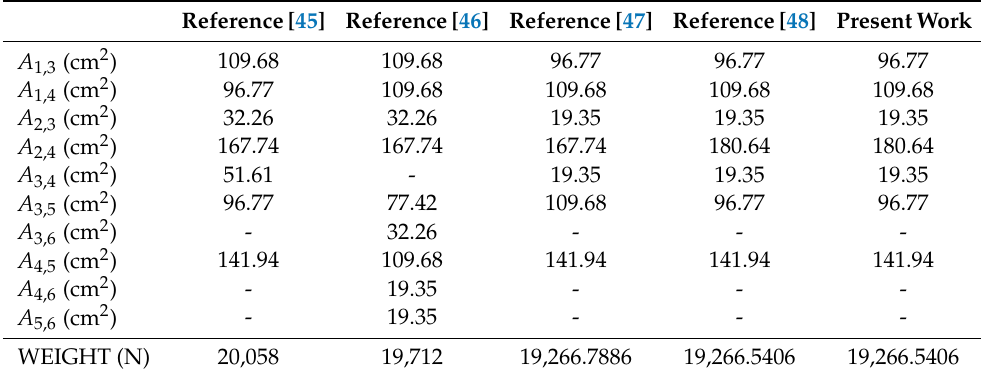
Table 9. Comparison of